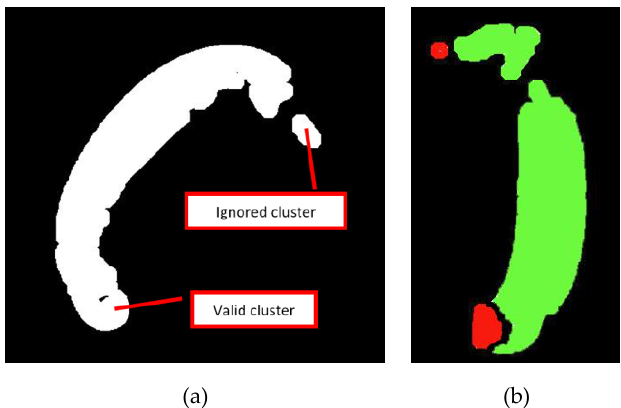
Figure 8. ( a ) Discrimination among valid and ignored clusters; ( b ) misclassification of small clusters: Red-colored clusters are discarded since their area is lower than the selected threshold (i.e., 200 pixels); green-colored clusters are counted, thus leading to counting error since both belongs to a single item.